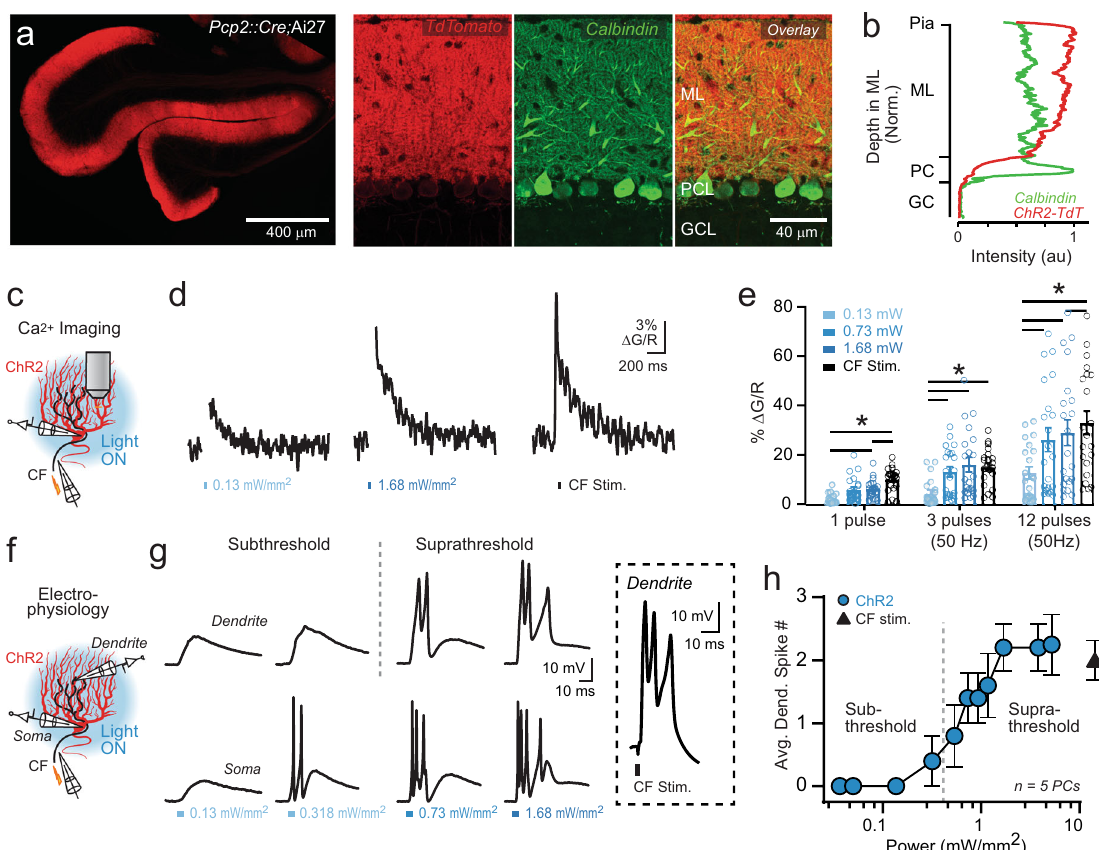
Fig. 1 Optogenetically evoked Ca 2 + signaling in PC dendrites. a Representative images from a single Pcp2::Cre; Ai27 mouse showing tdTomato-tagged ChR2 expression in the fl occulus. In the magni fi ed view, PCs are marked by calbindin immunostaining (molecular layer, ML; Purkinje cell layer, PCL; and granule cell layer, GCL). b The average fl uorescence intensity pro fi le of ChR2-tdTomato in the cerebellum of an example mouse. c ChR2-expressing PCs were fi lled with Fluo-5F during whole-cell recording. Two-photon imaging was used to measure Ca 2 + transients evoked by optogenetic excitation or climbing- fi ber (CF) stimulation. d Average Ca 2 + transients from the same PC dendrite evoked by single pulses of light ( λ 461 nm; 5 ms; artifacts blanked for clarity), shown relative to the climbing- fi ber-evoked response. e Summary plot of peak Ca 2 + transient amplitude for different stimulus conditions. In addition to single stimuli, trials also included bursts of closely spaced light pulses to elicit activity ( n = 21 dendritic sites obtained from seven PCs; six mice). Descriptive statistics: 1 pulse: 0.13 vs. 1.68 mW P = 0.0345, 0.13 mW vs. CF, P < 0.0001, 0.73 mW vs. CF, P = 0.0404; 3 pulses: 0.13 vs. 0.73 mW, P < 0.0001, 0.13 vs. 1.68 mW, P < 0.0001, 0.13 mW vs. CF, P < 0.0001; 12 pulses: 0.13 vs. 0.73 mW, P < 0.0001, 0.13 vs. 1.68 mW, P < 0.0001, 0.13 mW vs. CF, P resolution measurement of optogenetically induced electrogenic activity. g Electrophysiological responses from the same PC to single pulses of light at increasing powers ( λ 461 nm; 5 ms). The evoked dendritic response to climbing- fi ber stimulation is shown for a separate cell. h Plot shows the average number of optogenetically evoked dendritic spikes as a function of light power; the threshold for evoking reliable dendritic spiking is indicated by the dashed line. All data are mean ± SEM; asterisk indicates P < 0.05, two-way repeated-measures ANOVA with Tukey ’ s post signaling in PC dendrites is ampli fi ed by regenerative electrogenic activity. Notably, at high-light powers (>1.0 mW/mm 2 ), the optogenetically evoked electrical waveform in the dendrite closely resembled the response elicited by climbing- fi ber-mediated excitation (Fig. 1g, h), an input that drives somatically uncoupled bursts of dendritic Ca 2 + action potentials 36 . Together, these results indicate that optogenetic PC activation produces a range of dendritic Ca 2 + signals, which are partially dependent on ampli fi cation by regenerative dendritic spiking; an electrogenic response mimicking those elicited by climbing- fi ber-evoked excitation.